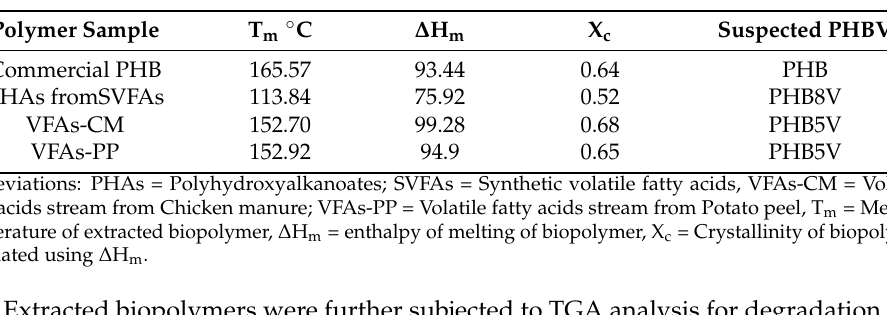
Table 4. Comparison of DSC data for produced biopolymers with commercial PHB.